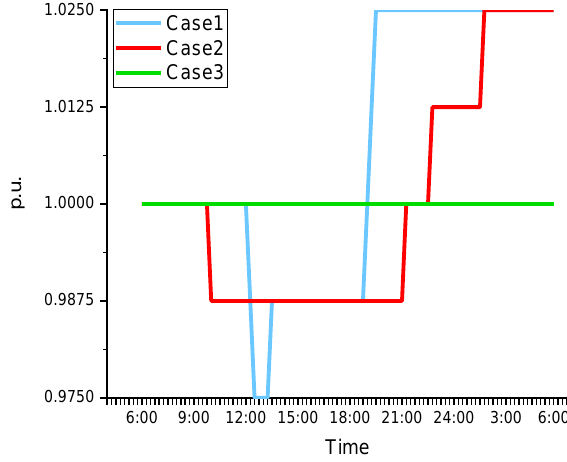
Figure 8. Three kinds of OLTC adjustment times chart.